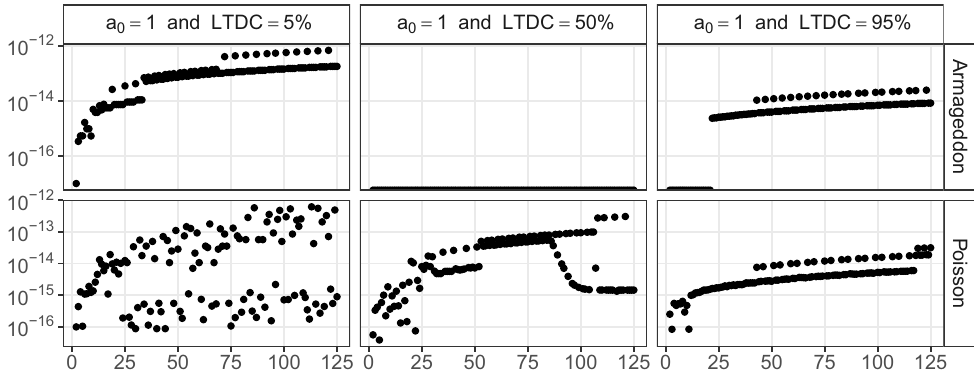
Figure 4: The maximum total variation distance ( ) ε d 2 of the transition distributions of the proposed and high - precision calculation of ∗ Q for ≤ ≤ d 2 50